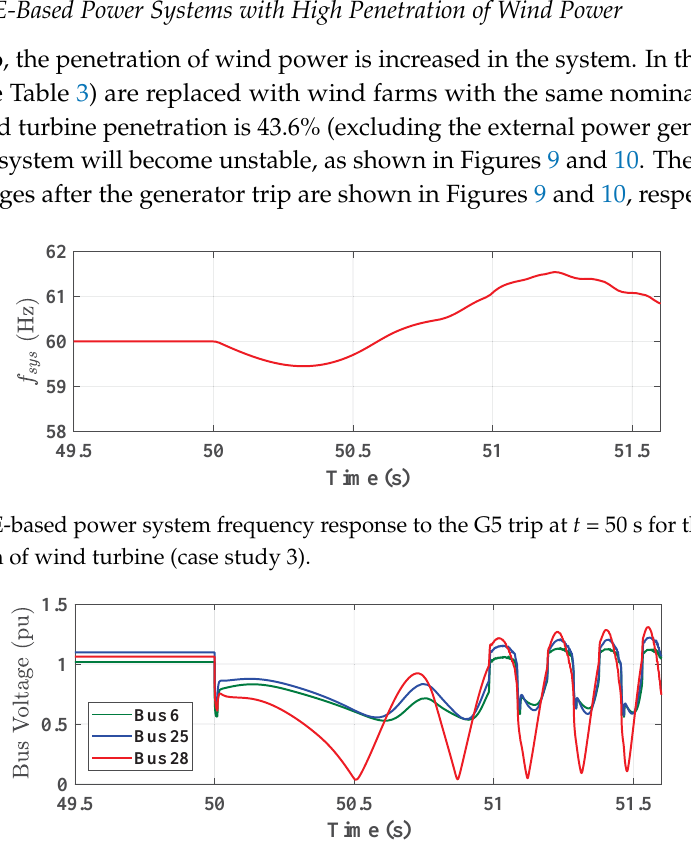
Figure 10. Bus 6, 25, and 28 voltage magnitude responses to G5 trip at t = 50 s for the system with a high penetration of wind turbine (case study